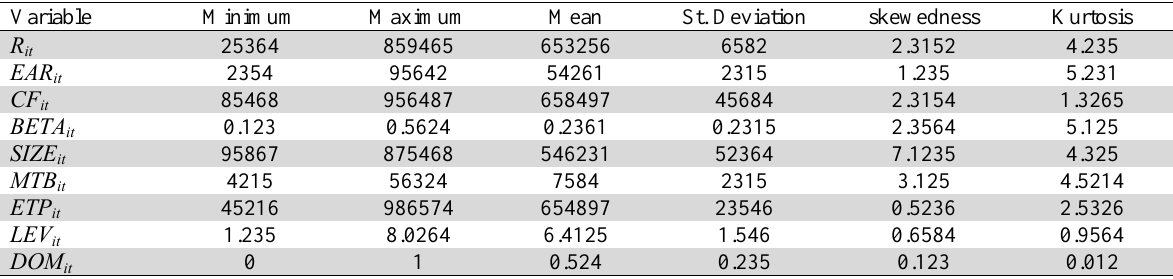
Summary of Description